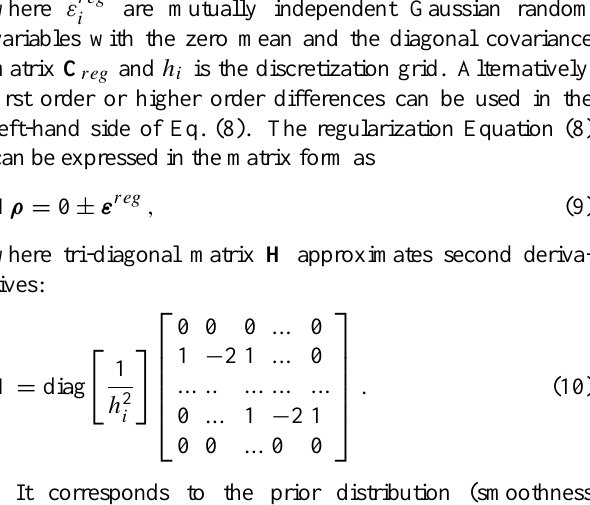
Table 1. Target resolution for ozone used in the